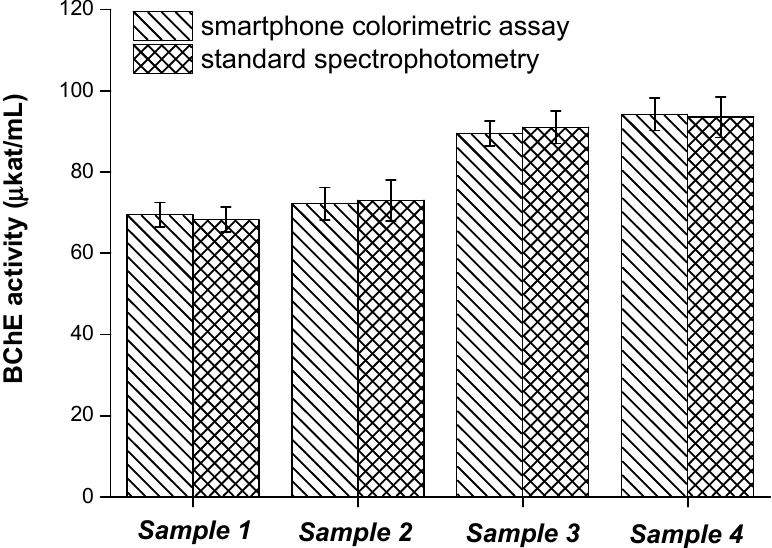
Figure 11. The assay of plasma samples by standard spectrophotometry and by the newly developed smartphone camera-based colorimetric assay. A 60 min incubation was chosen for this experiment. Standard error of the mean is expressed for five independent repeats. BChE butyrylcho- linesterase.